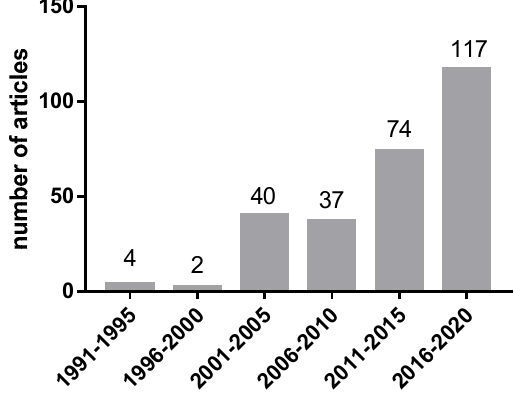
Figure 1. The number of articles retrieved on PubMed using searching terms “blackcurrant” and “anthocyanins” over different periods.